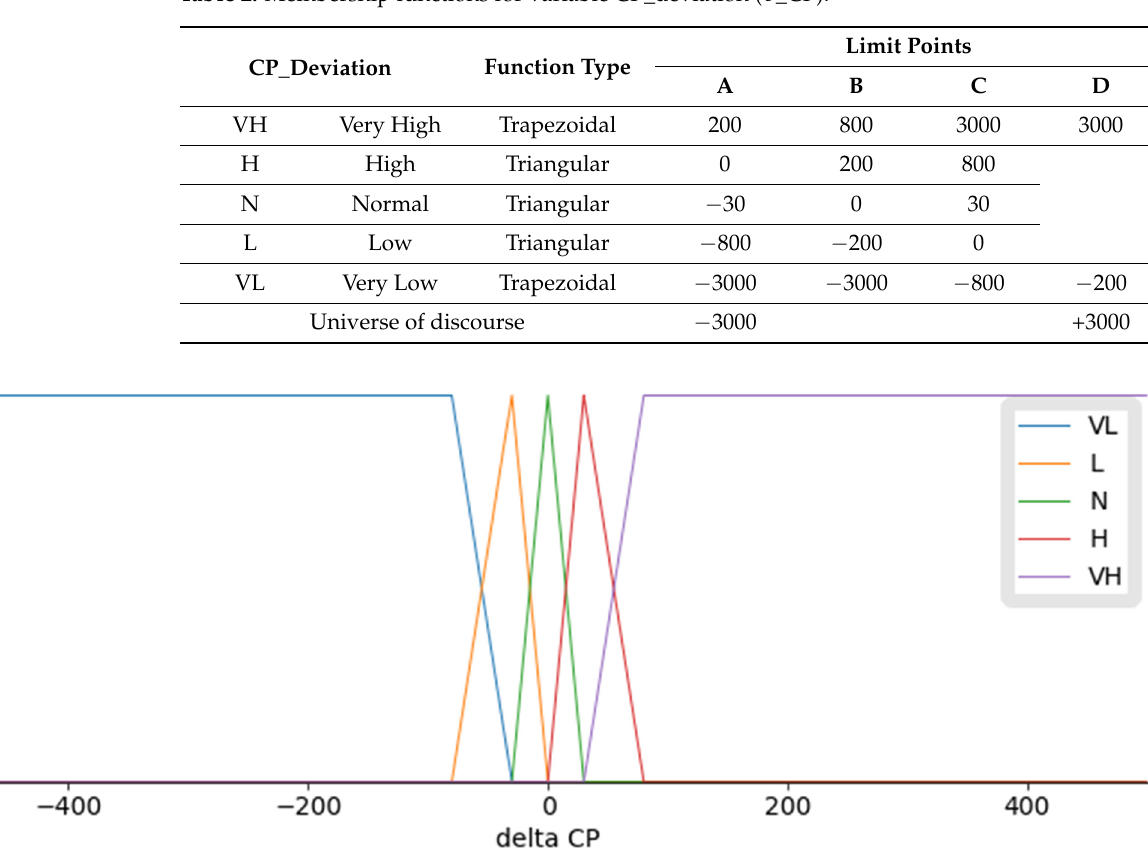
Figure 5. Graphical description of variable CP_deviation ( σ CP